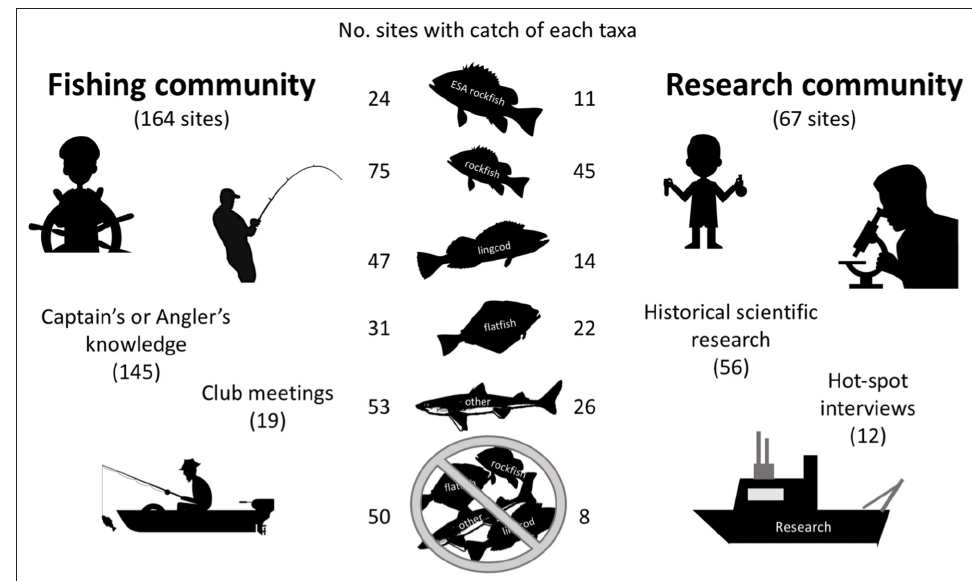
Figure 4: Summary of contributions by recreational fishing and research communities to site selection and number of sites with catch of major Puget Sound taxa categories during the population genetics study of ESA-listed rockfish in Puget Sound, WA, USA. Number of sites in each column will not add up to total number of sites due to multiple taxa being caught at the same sites.